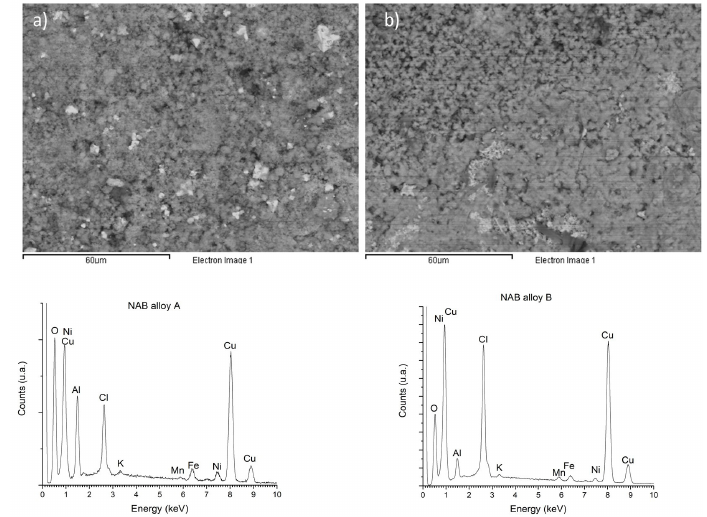
Figure 9. SEM images and EDX point analysis of the NAB surfaces after electrochemical corrosion tests for NAB alloy A (a) and NAB alloy B (b), Table 4. Summary of the experimental data derived from the corrosion immersion test and potentiodynamic polarization curves of the Tafel method. Type of sample